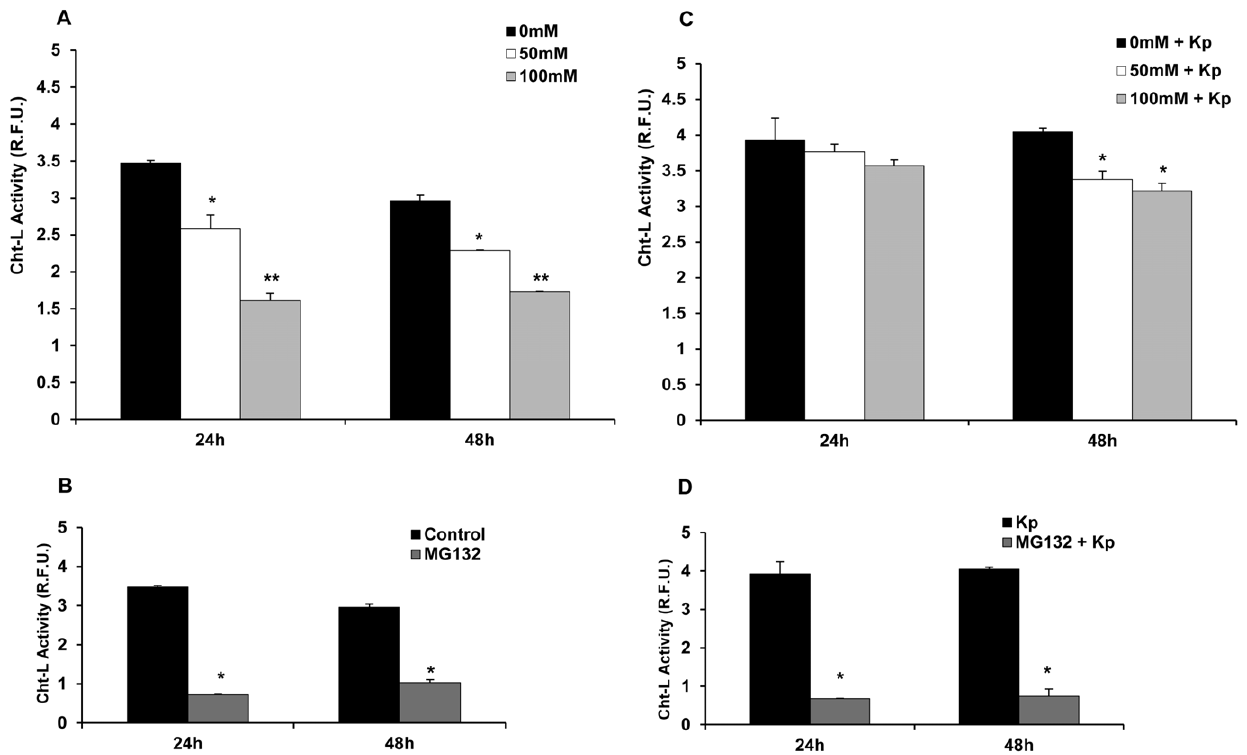
Figure 1. 20S chymotrypsin-like (Cht-L) proteasome activity is suppressed in ethanol-treated RAW 264.7 cells. A. Murine RAW 264.7 (2 6 10 5 cells/ml) cells were treated with 50 mM or 100 mM ethanol (EtOH) for 24 h or 48 h. 0 mM (control) cells received no treatment. Cell lysates obtained at the indicated time points were analyzed for 20S Cht-L proteasome activity by fluorigenic assay as described in Methods. B. RAW 264.7 cells were treated with MG132 (0.5 uM) as a positive control of proteasome suppression. Cell lysates were analyzed at the indicated time points for proteasome activity as described in panel A. C. Ethanol-treated RAW 264.7 cells were stimulated with heat-killed K.pneumoniae ( Kp ), 6 hours after initial EtOH exposure. Cell lysates obtained at the indicated time points were analyzed as described above in panel A. D. RAW 264.7 cells were treated with MG132 (0.5 uM) followed by challenge with Kp as described in panel C. Cells were lysed at the indicated time points and analyzed for proteasome activity as described above. Proteasome activity data was plotted as mean relative fluorescence units (R.F.U.) 6 SEM (three replicates per experiment) and is representative of three independent experiments. Higher R.F.U. values indicate higher proteasome activity. *p , 0.05 vs. control (0 mM) at the respective time point. **p , 0.05 vs. control (0 mM) and 50 mM EtOH at the respective time